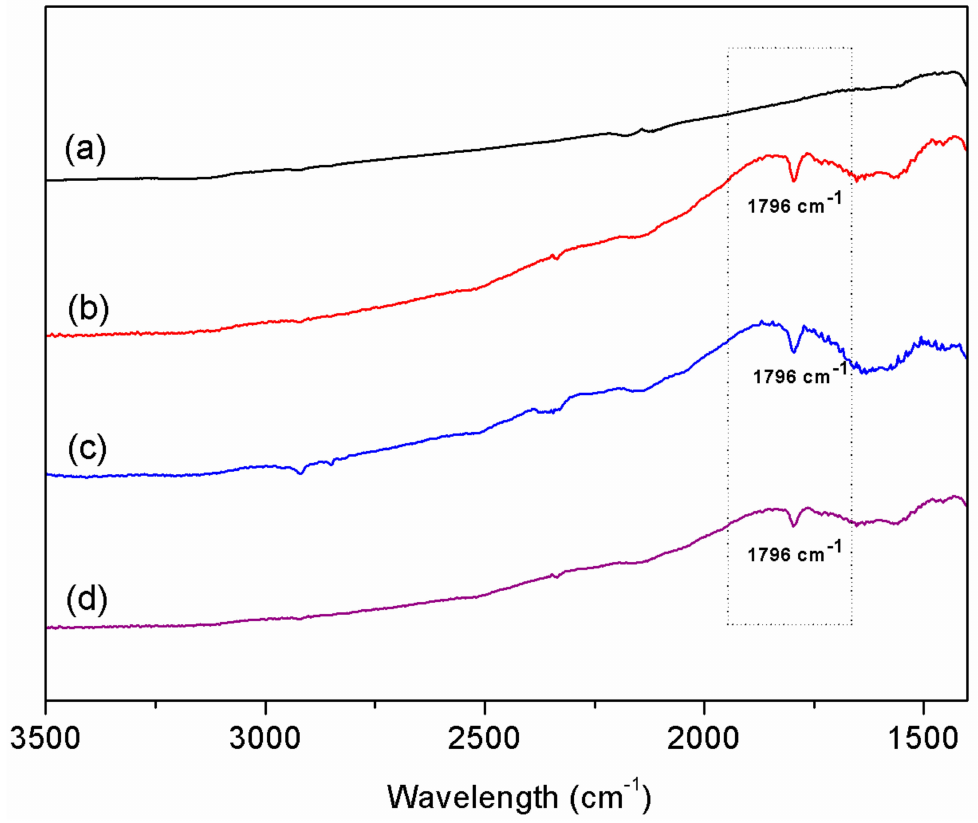
Figure 8. FT-IR spectra of ( a ) FeSe 2 obtained from the reaction with CO only, ( b ) FeSe 2 obtained from the reaction in CO / O 2 gas mixture ( v / v = 80:20), ( c ) FeSe 2 obtained from the reaction with CO by adding NB as oxidant, ( d ) spent FeSe 2 after the carbonylation